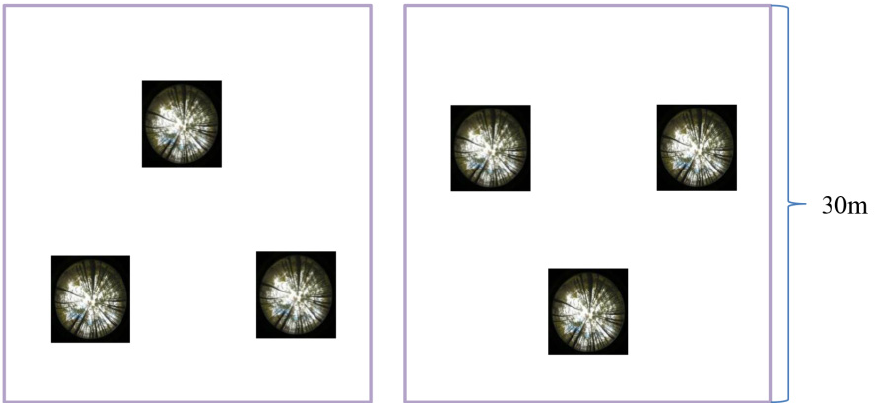
Table 1. Statistical information of field plots including the number of field plots, stands density of field plots, and FCC of camphor pine and white birch. FCC refers to the mean forest-canopy clo- sure of field plots. SPs is the abbreviation of sparse plots; MDs is the abbreviation of medium den- sity plots; DDs refers to dense plots.